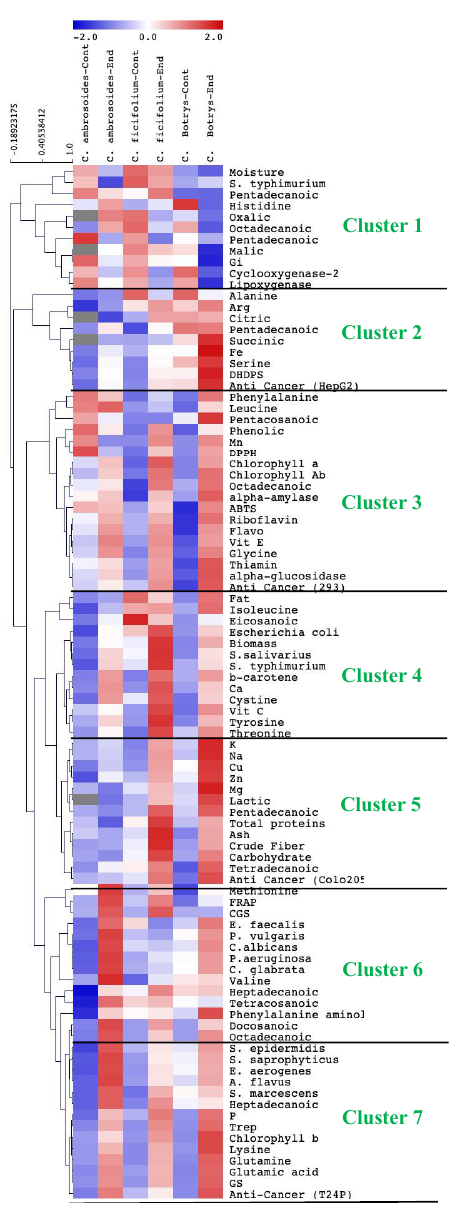
Figure 4. Species-specific responses of Chenopodium ambrosoides, Chenopodium ficifolium, and Chenopodium botrys sprouts to the effect of endophytic bacterial treatment on the nutritional and health-promoting properties. The measured parameters are represented by amino, fatty, and organic acids; antioxidant capacity; the contents of pigments, minerals, and vitamins; and antibacterial, antidiabetic, anti-inflammatory, and anticancer activities. Data are represented by the means of at least 3